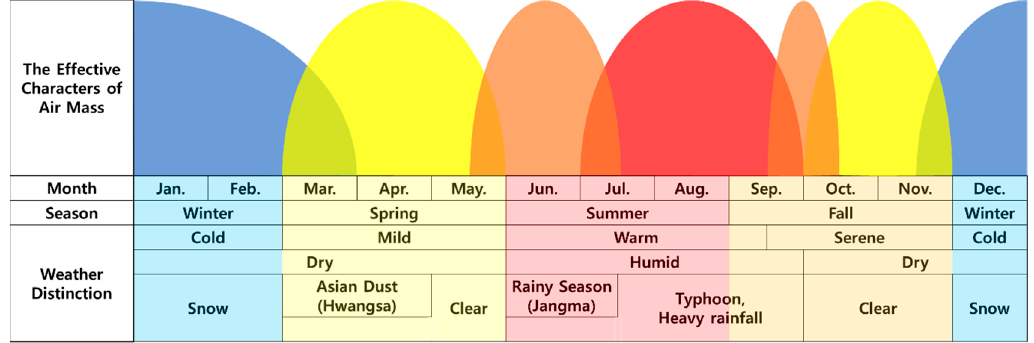
Figure A1. Seasonal climate characteristics of South Korea (https://www.kma.go.kr).